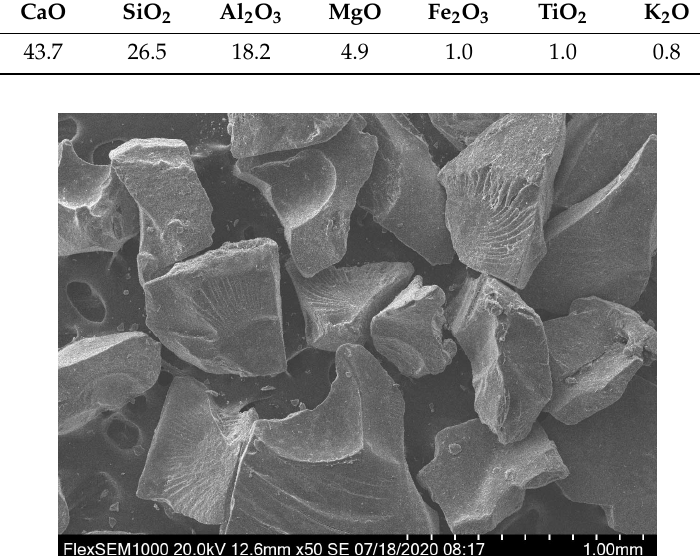
Figure 2. SEM image of SAP powders.